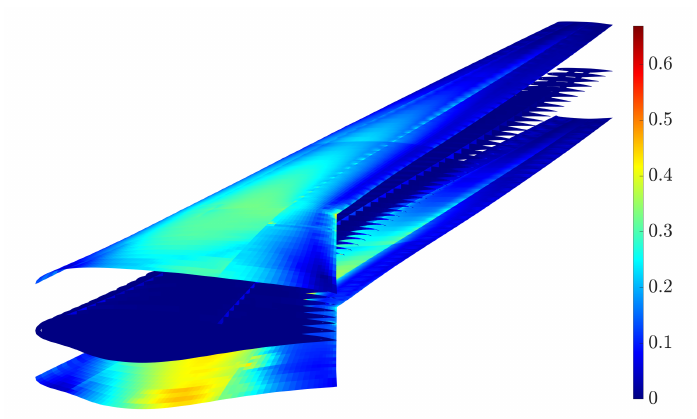
Figure 16. SBO optimal design—deflected shape.